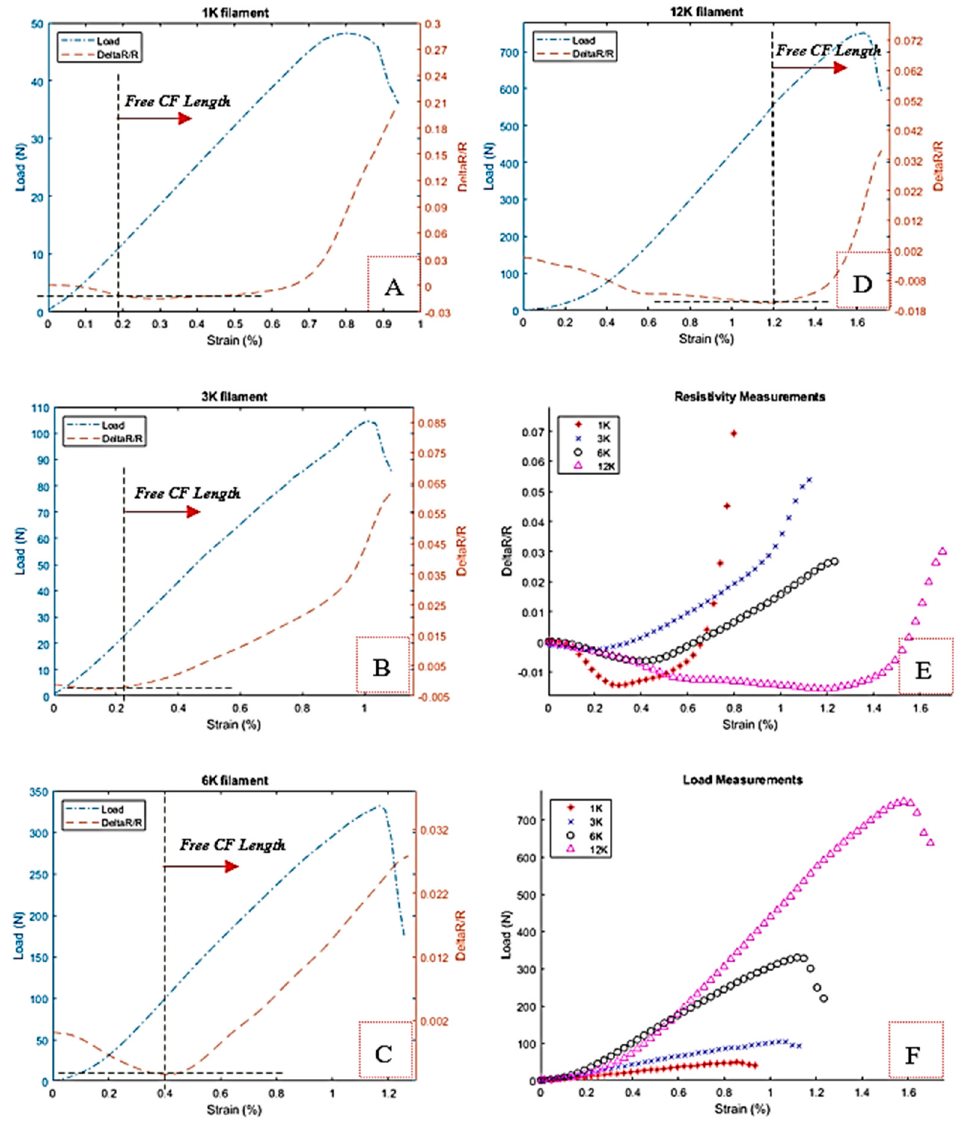
Figure 9. Bare fiber resistance change and the tensile test load versus the tensile strain for ( A ) 1 K, ( B ) 3 K, ( C ) 6 K, ( D ) 12 K, and combined results for all tow filaments versus strain; ( E ) resistances and ( F ) loads.